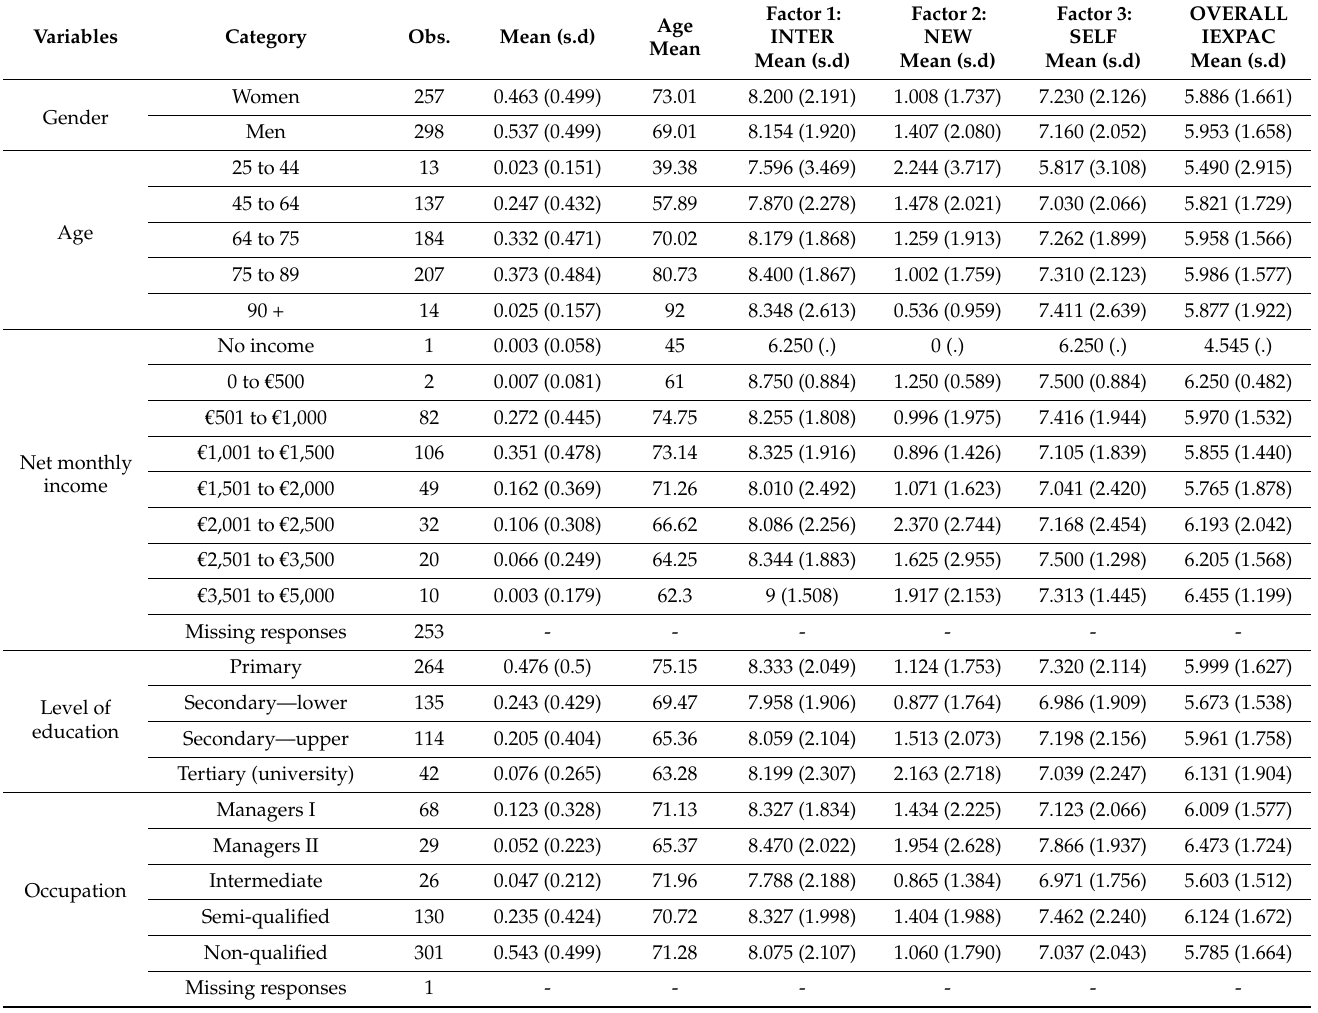
Table 1. Sociodemographic and economic variables. Descriptive statistics.